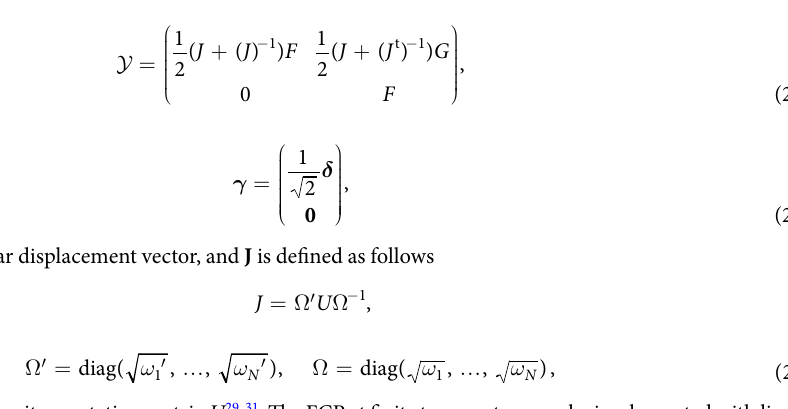
Figure 3. Squeezing parameters of the photoelectron spectroscopy of sulfur dioxide anion ( SO different temperatures. The squeezing parameters in dB is obtained as − 10log (e ) s and one of the diagonal matrix elements of 